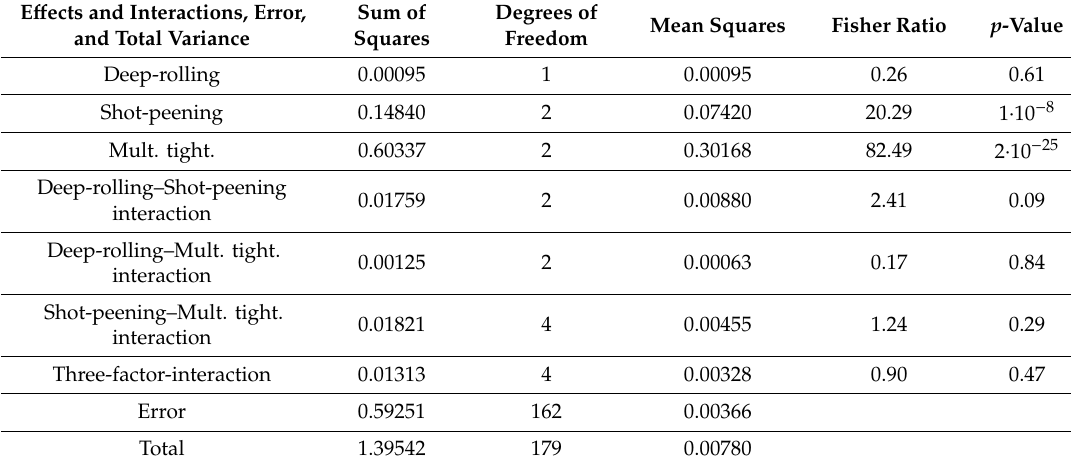
Table 7. Analysis of variance (ANOVA) table with regard to the bearing friction coe ffi cient ( µ b ) in dry